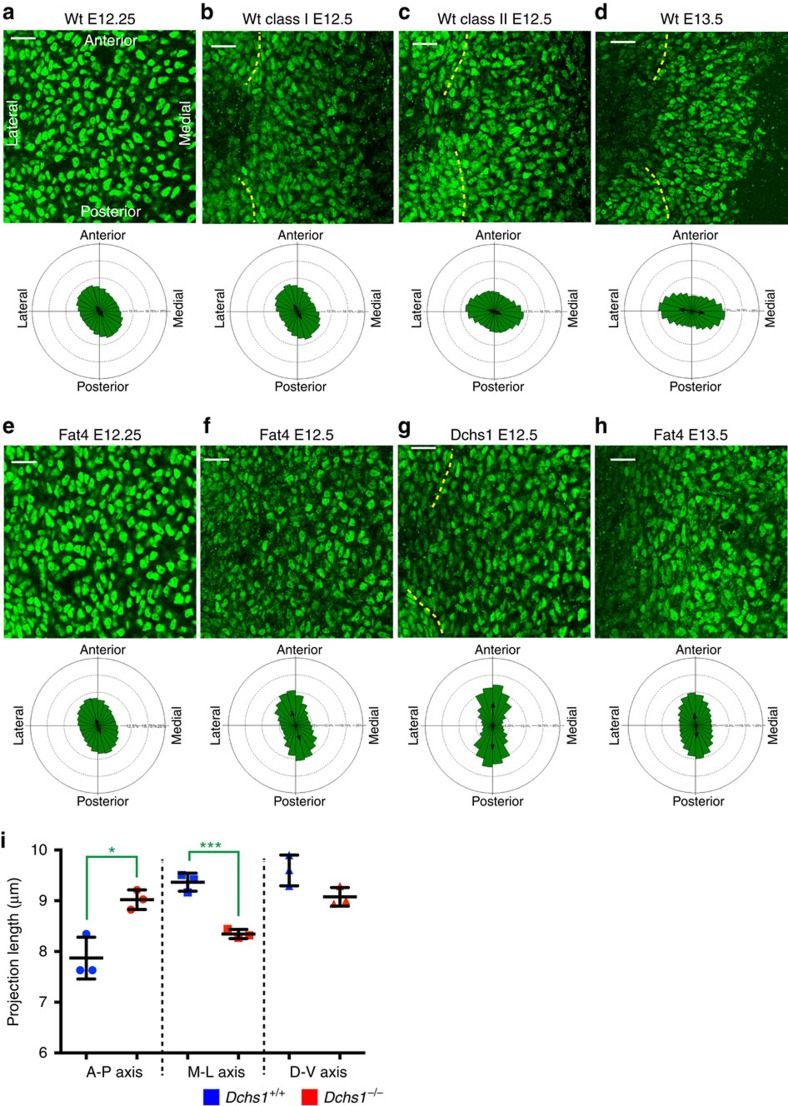
Analysis of sternal cell nuclear orientation in wild type and in mutants.(a–h) Flatmounts of E12.25 (a,e), E12.5 (b,c,f,g) and E13.5 (d,h), from wild type (a–d), Dchs1−/− (g) and Fat4−/− (e,f,h) sterna immunostained for Sox9 (green) to mark sternal nuclei. Orientation of the nuclei is shown in the rose plots below. The lateral edges of the sterna are indicated by dashed lines. The anterior-posterior and medio-lateral axes are defined in a. The total numbers of cells analysed are as follows: wt; E12.25, 40,569; E12.5, class I 15,837; E12.5 class II, 23,149; E13.5, 46,042; Fat4−/−, E12.25, 40,468; E12.5, 30,443; E13.5, 59,152; Dchs1−/−, E12.5, 2,484; E13.5, 2,575. (i) Quantitation of projection length of nuclei along anterior-posterior (A-P), medio-lateral (M-L) and dorso-ventral (D-V) axes (see Supplementary Fig. 3a–f for an example of the analysis; n=3, >1,500 cells analysed per embryo). The lines indicate mean (thicker black bar), 25 and 75%. Student's t-test: *P<0.05, ***P<0.001. Scale bar, 25 μM.